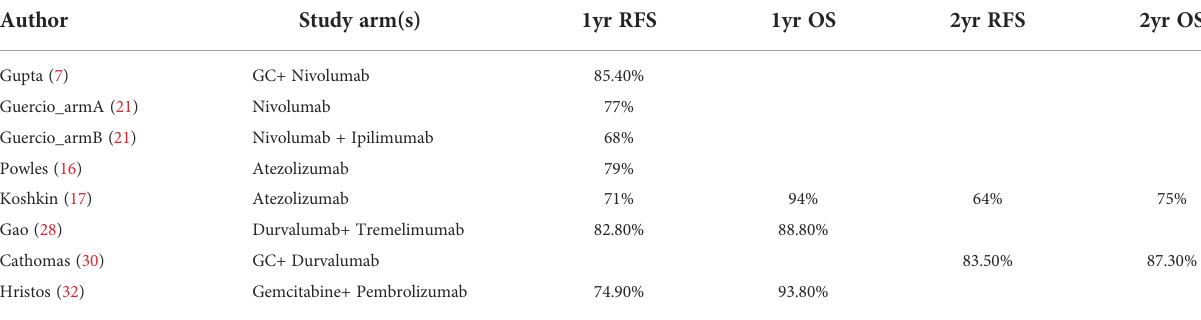
TABLE 4 Most frequently reported survival